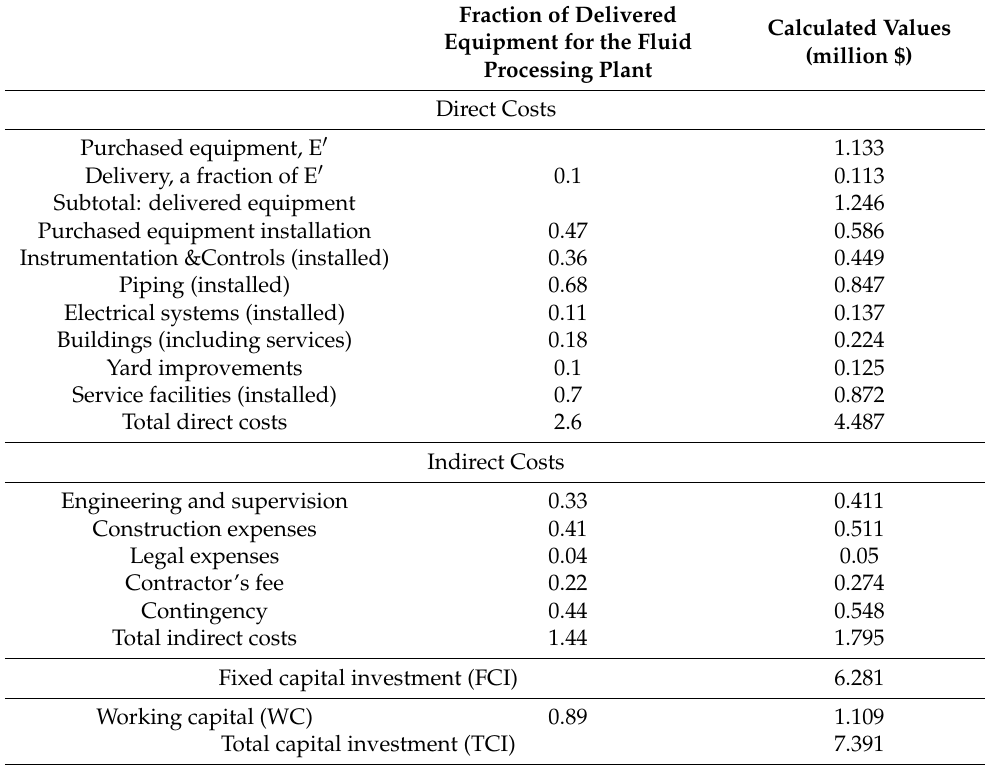
Table 8. Details of total capital investment calculations [29].